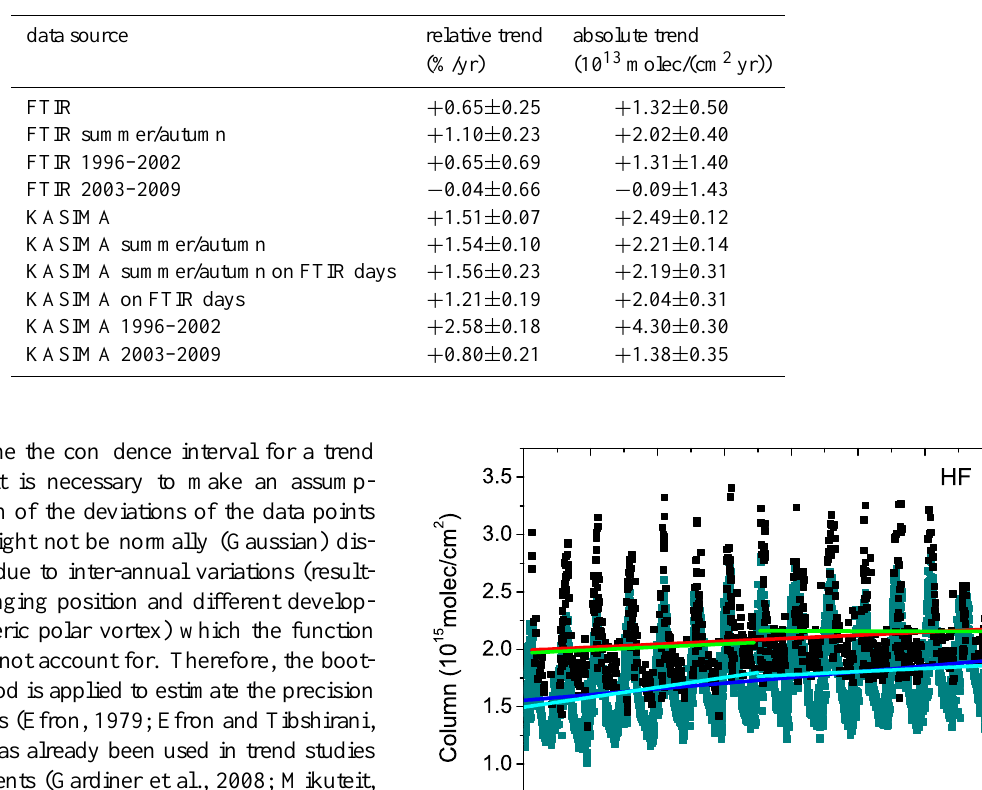
Table 1. Absolute and relative trends for HF column abundances from the FTIR measurements and KASIMA model calculations for Kiruna. The time range considered is 1996–2009 unless otherwise identified. The “summer/autumn” time series contain the data between June and November only.